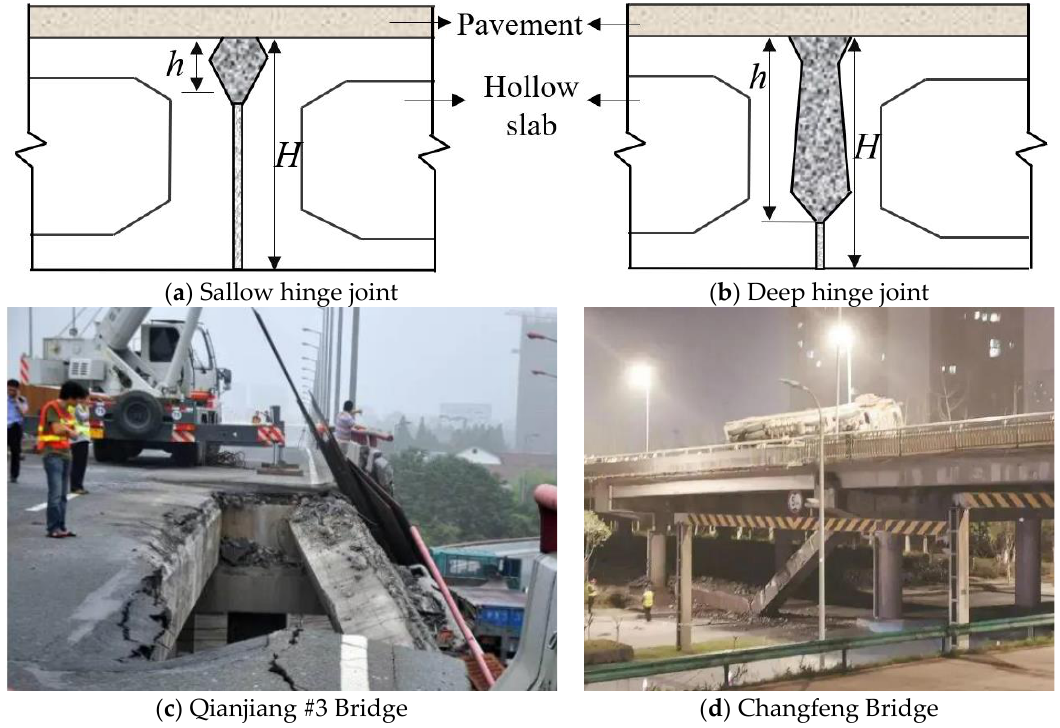
Figure 1. Pictures of slab failure.